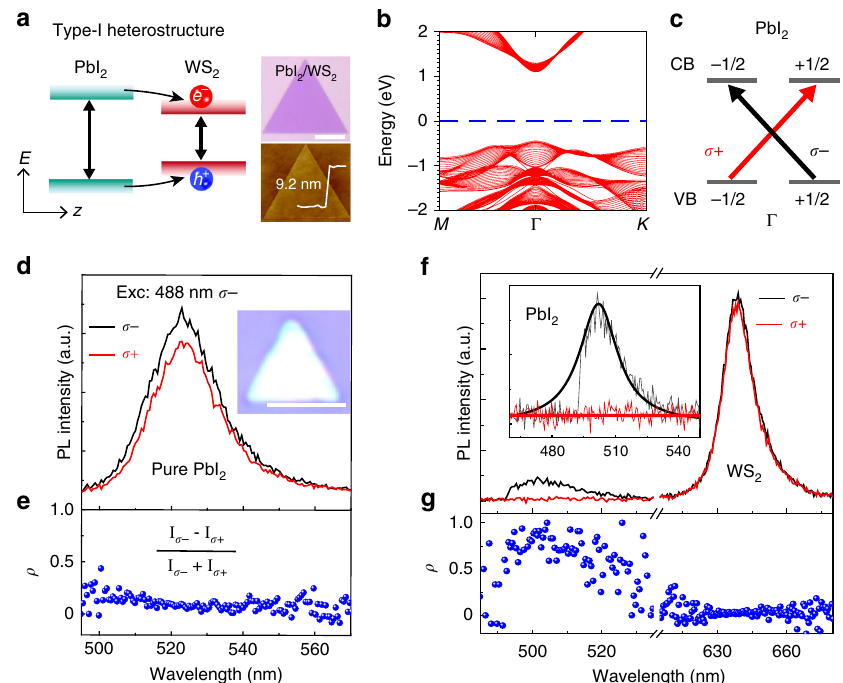
Fig. 1 Spin polarization mechanism and spectrum of PbI 2 /WS 2 heterostructures. a Schematic of the type-I heterostructure for the study of the carrier interlayer transportation. Both electrons and holes transfer from PbI 2 to WS 2 . The images on the right are optical and AFM micrographs of a PbI 2 /WS 2 heterostructure with a thickness of 9.2 nm. b Band structure for the PbI 2 thin fi lm with a thickness of 20 layers, which is spin degenerate. c Schematic illustration of the polarized optical transitions in PbI 2 thin fi lms. d Circularly polarized PL spectra from pure PbI 2 at room temperature. e Corresponding degree of polarization ρ of pure PbI 2 PL calculated from the PL spectra shown in fi gure ( d ). f Circularly polarized PL spectra of a representative PbI 2 /WS 2 heterostructure at room temperature. g Corresponding degree of polarization ρ calculated from the PL spectra shown in fi gure ( f ). All length of the scale bar is 10 µ